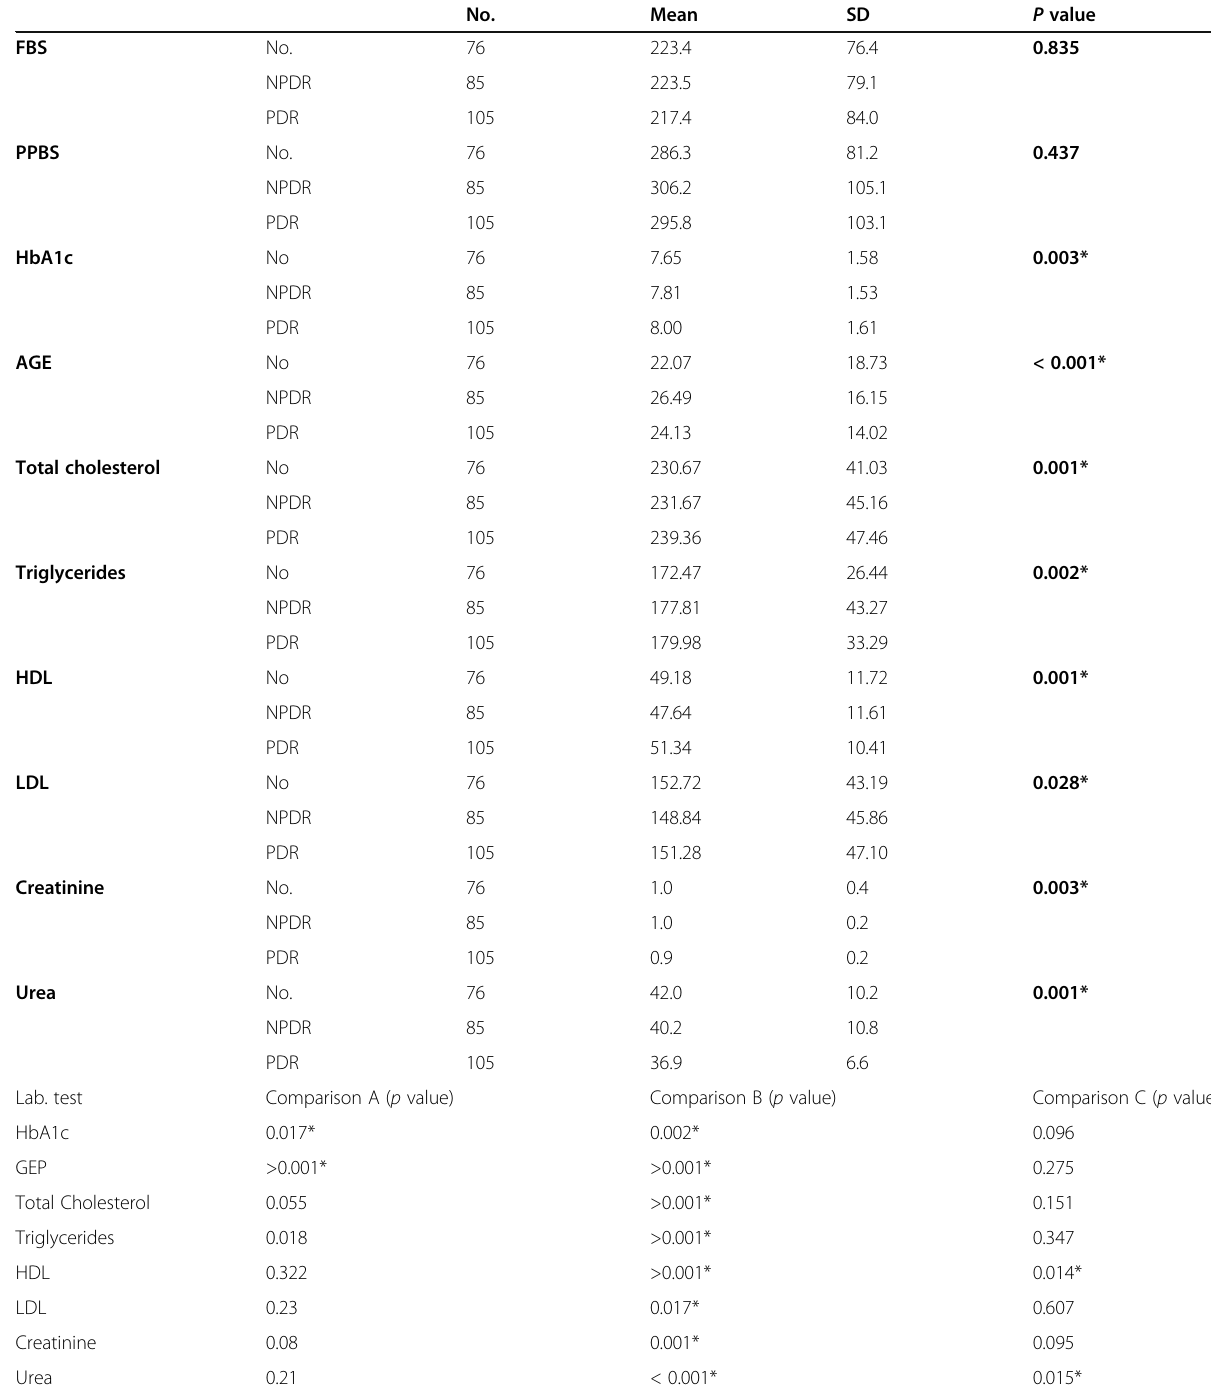
Table 2 Laboratory investigations of diabetics grouped according to DR types